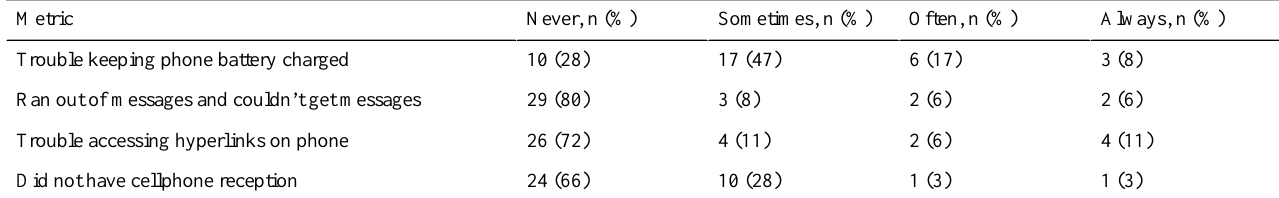
Table 2. Intervention delivery metrics.